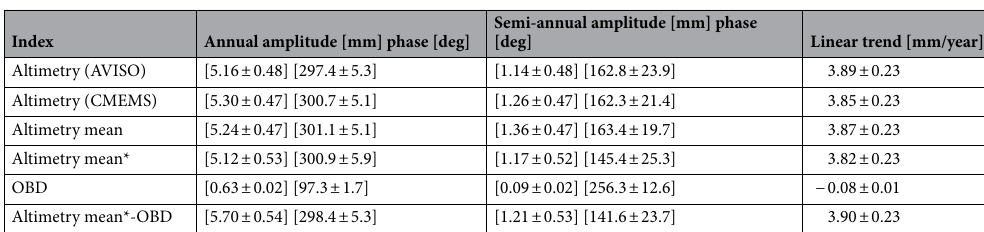
Table 2. Amplitudes of annual and semiannual components and linear trends of global mean sterodynamic sea-level change from Altimetry observations for the period January 2005 to December 2019. The uncertainty represents the least-squares fitting error (1 sigma for amplitudes, phases and trends) except the linear trend (± 0.23 mm/year) estimated as Barnoud et al. 17 . Same missing months as GRACE/GRACE-FO data are deleted from Altimetry data, the corresponding re-estimated results are given as